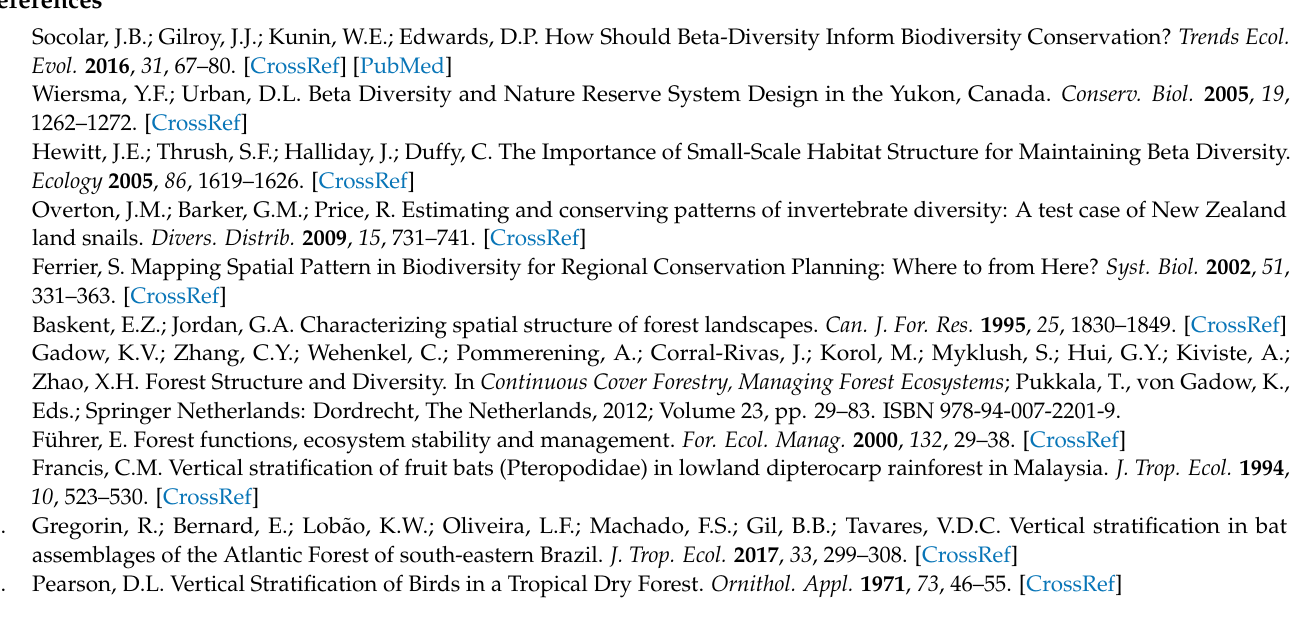
Figure A14. NMDS plot demonstrating the influence of tree species on the overall beta diversity for the common beetle species ( a ) and the rare beetle species ( b ), rarity classification according to the